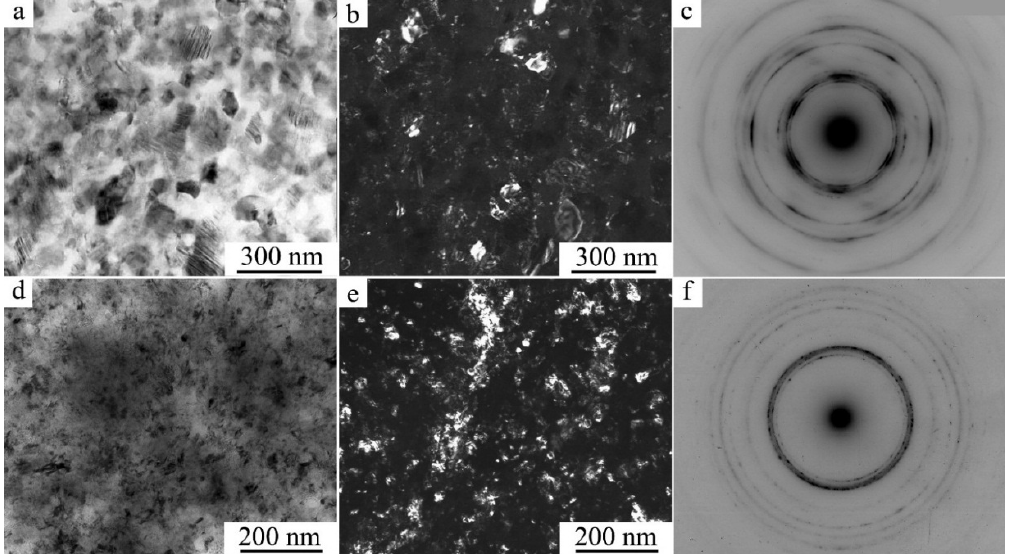
Figure 28. ( a , d ) Bright- and ( b , e ) dark-field TEM images (amplitude contrast) of the microstructure and ( c , f ) the corresponding SAED pattern for the ( a – c ) Cu–14Al–3Ni alloy and ( d – f ) Cu–13.5Al–3.5Ni after its quenching from 1223 K and HPT of 10 revs [46,64]. Annealing martensite at 373 and 473 K according to SEM data did not lead to notice- able dimensional and morphological changes in the martensitic UFG structure formed as